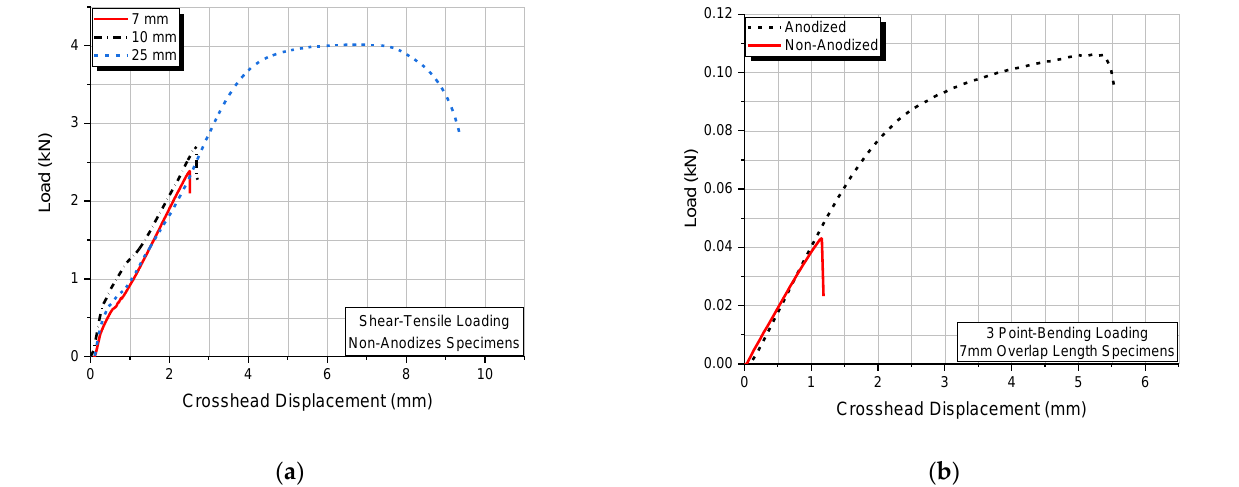
Figure 7. Comparative values of the shear strength of aluminum adhesive joints with non-anodized and anodized ad- herends: ( a ) for Araldite adhesive and ( b ) for RenLam adhesive.